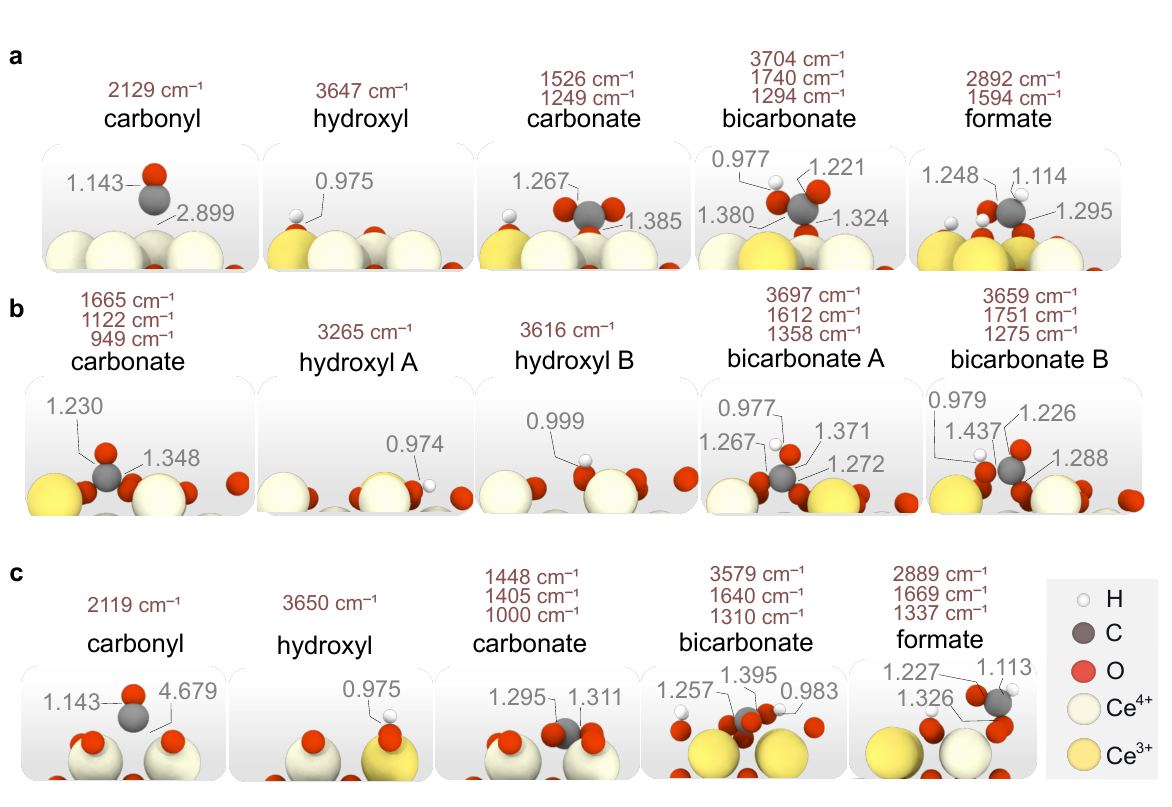
Figure 5. Representation of the most energetically favorable adsorption modes for CO, CO 2 and H 2 on stoichiometric ( a ) CeO 2 (111), ( b ) CeO 2 (110), ( c ) CeO 2 (100). Calculated vibrational frequencies (in cm − 1 ) and relevant distances (in Å) are also